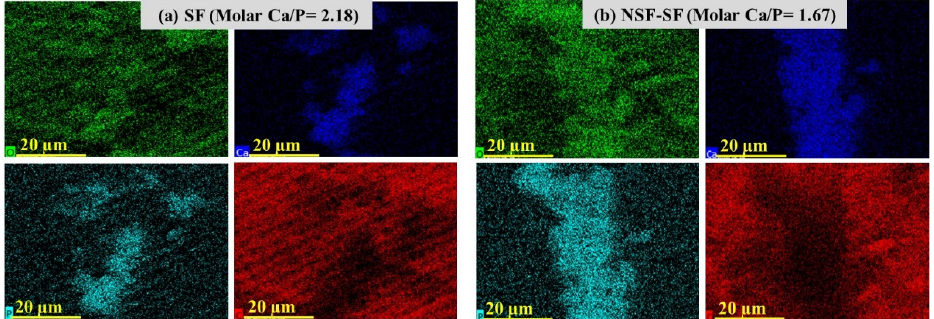
Figure 5. Elemental mapping showing the Ca (blue), P (turquoise), and O (green) distribution on biomineralized ( a ) SF and ( b ) NSF-SF.